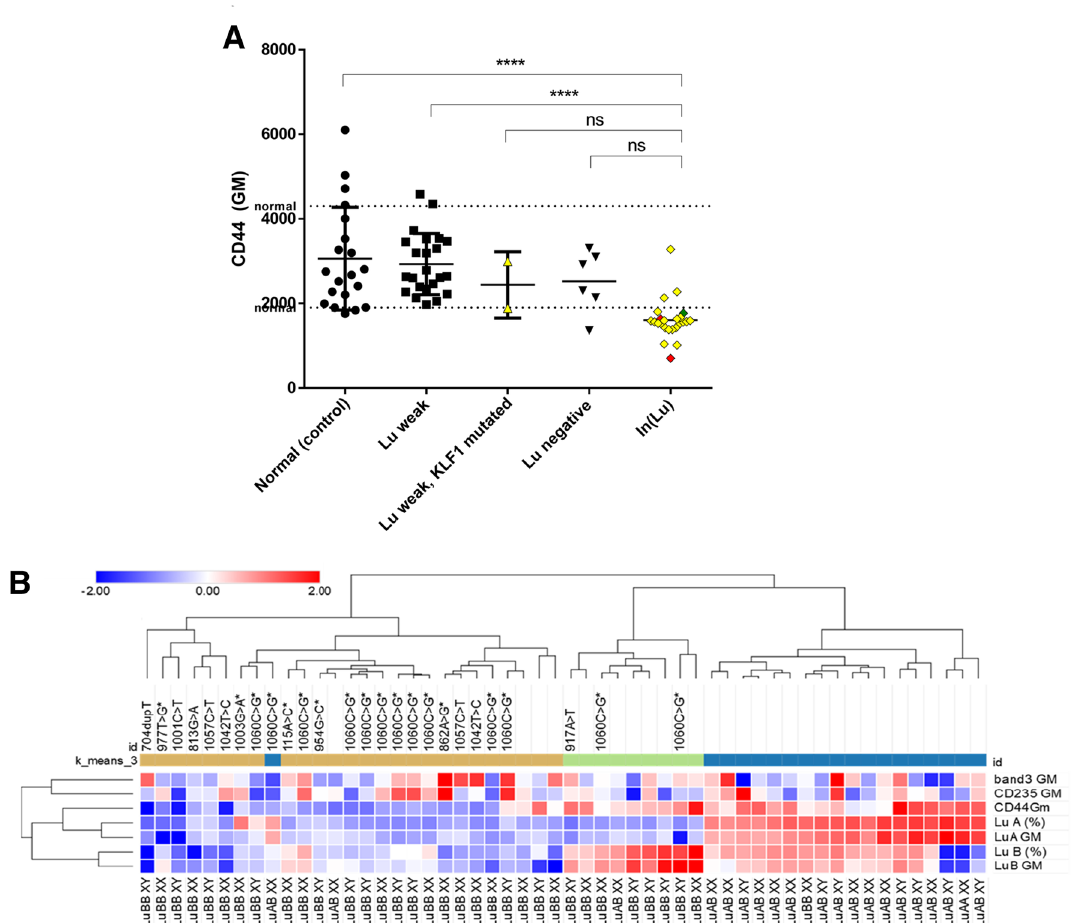
Figure 3. KLF1 mutants show significant decreased CD44 expression compared to control donors. (A) FCM MFI (mean fluorescence intensity) of CD44 on erythrocytes. Donors were grouped based on presence of KLF1 variants and Lu expression. The colors resemble the KLF1 variant class (on a scale of 1–3 indicating severity of the variant). Color nodes: green; class 1, yellow; class 2 and, red; class 3. The dotted line represents the normal value of CD44 expression. CD44 protein expression was plotted against the Lutheran phenotype as evaluated by FCM (Fig. 1). Dots represent the average MFI of three single individual measurements (*** indicates a P